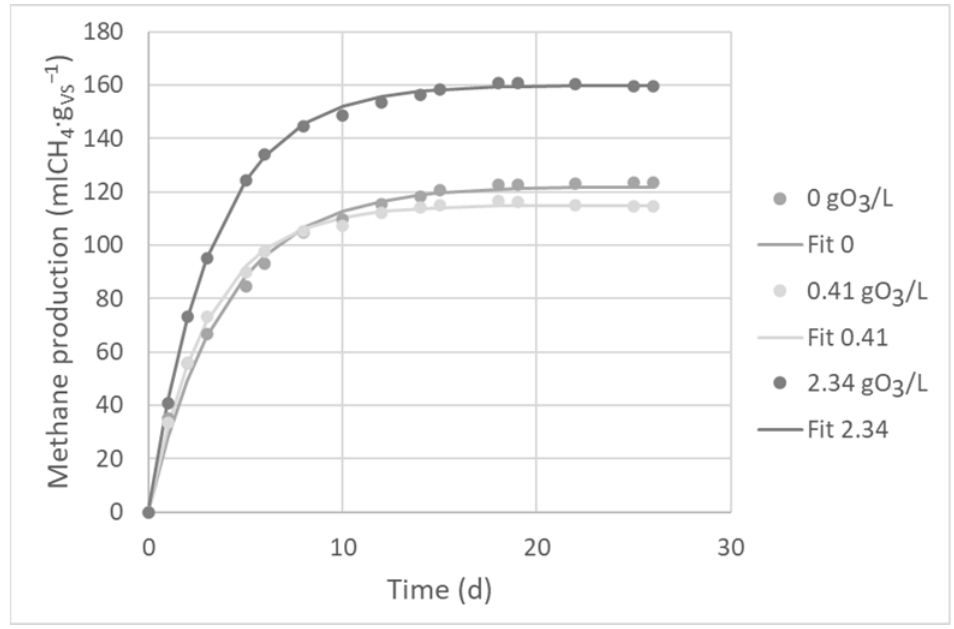
Table 4. Kinetic parameters obtained for methane production.